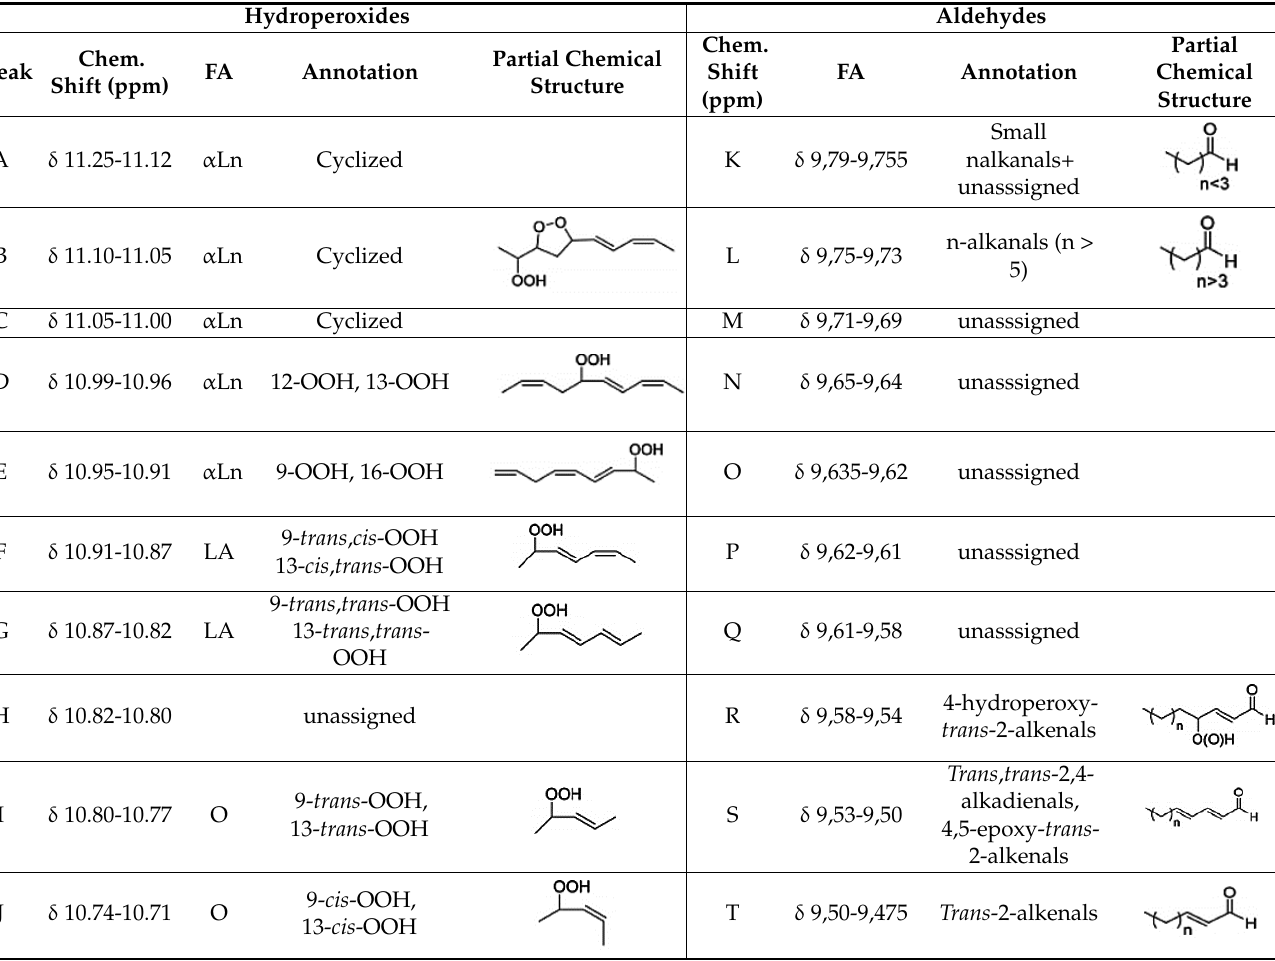
Table 5. Signal assignments of the peroxides and aldehydes annotated in Figure 35. Reprinted with permission from [135]. Copyright 2018, American Chemical